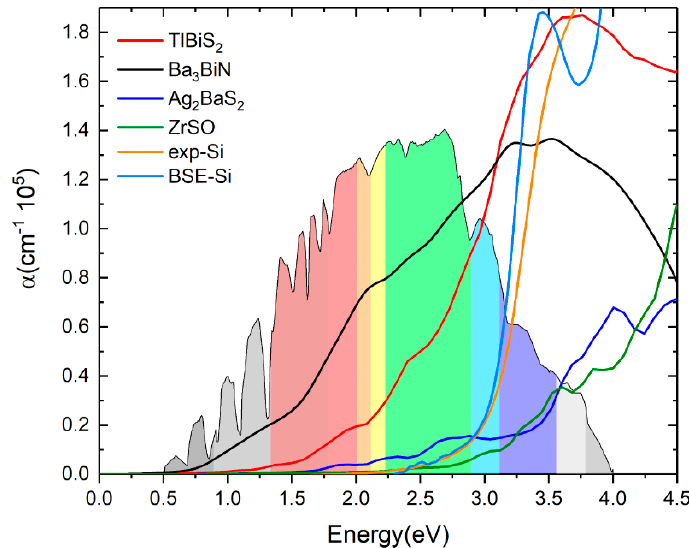
Figure 8. Optical absorption coefficients of TlBiS 2 , Ba 3 BiN, Ag 2 BaS 2 and ZrSO. For comparison, we plotted the silicon optical absorption coefficient (color code: orange—experimental absorption coefficient of Si, navy blue—BSE calculation of Si).